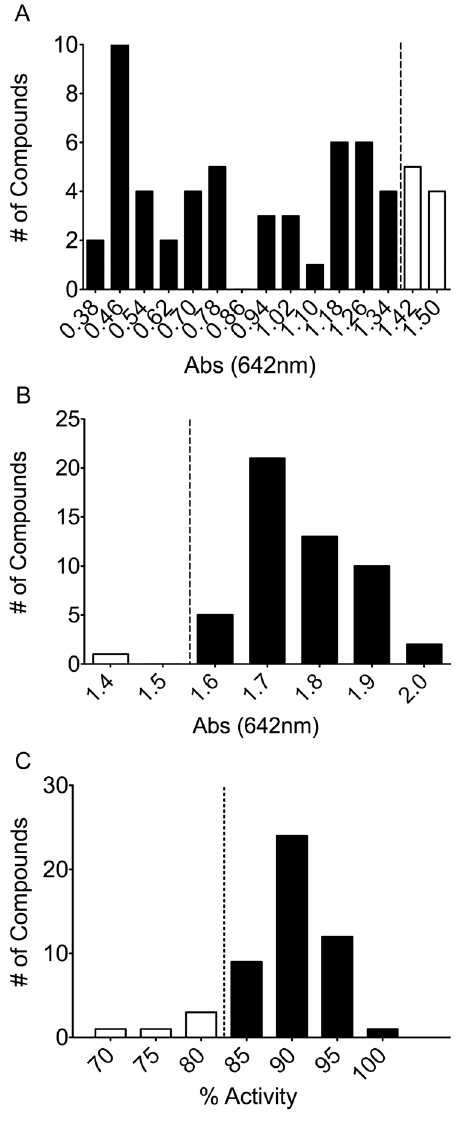
Figure 6. Single Point Hit Confirmation and Control Screens. (A) Single point hit confirmation assay was an analysis of each of the initial hits in a 384-well format (40 m M final for each compound). 7 compounds fell within 3 standard deviations of the negative control and were excluded from further analysis. (B) Phosphate control assay was a comparison of each compound’s (40 m M final) ability to inhibit the assay itself, containing 50 m M phosphate instead of protein. Dashed line represents 3 standard deviations from the negative control. 1 compound fell below 3 standard deviations and was excluded from further analysis. (C) At 40 m M final for each compound, the G a i control assay evaluated each compound for inhibition of G a i (5 m M final). The dashed line represents 3 standard deviations below the negative control. 5 compounds fell below 3 standard deviations and were excluded from further analysis. Filled bars represent compounds carried over to following experiments. Open bars represent compounds excluded from further